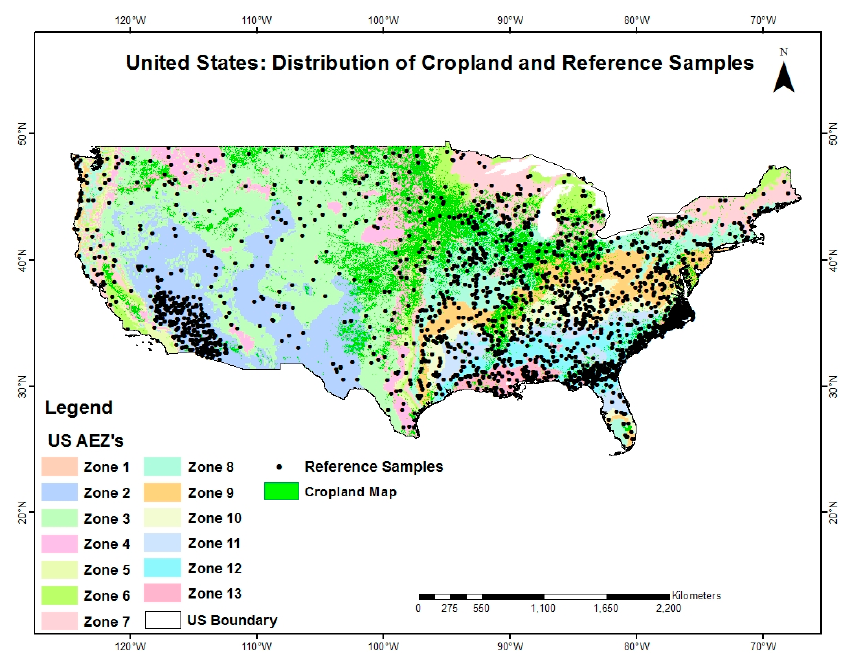
Figure 5 . The distribution of randomly generated reference samples within each of the AEZ’s of the US.